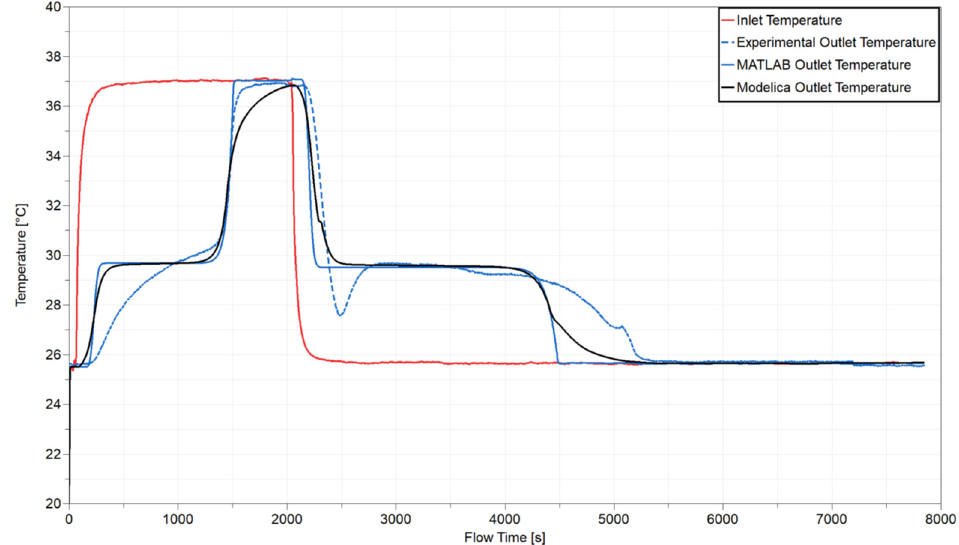
Figure 10. Comparison of experimental data with model predictions of LHS outlet temperature (Copyright 2020 Helmns et al. (http://creativecommons.org/licenses/by/4.0/), accessed on 26 Sep- tember 2022) [36].